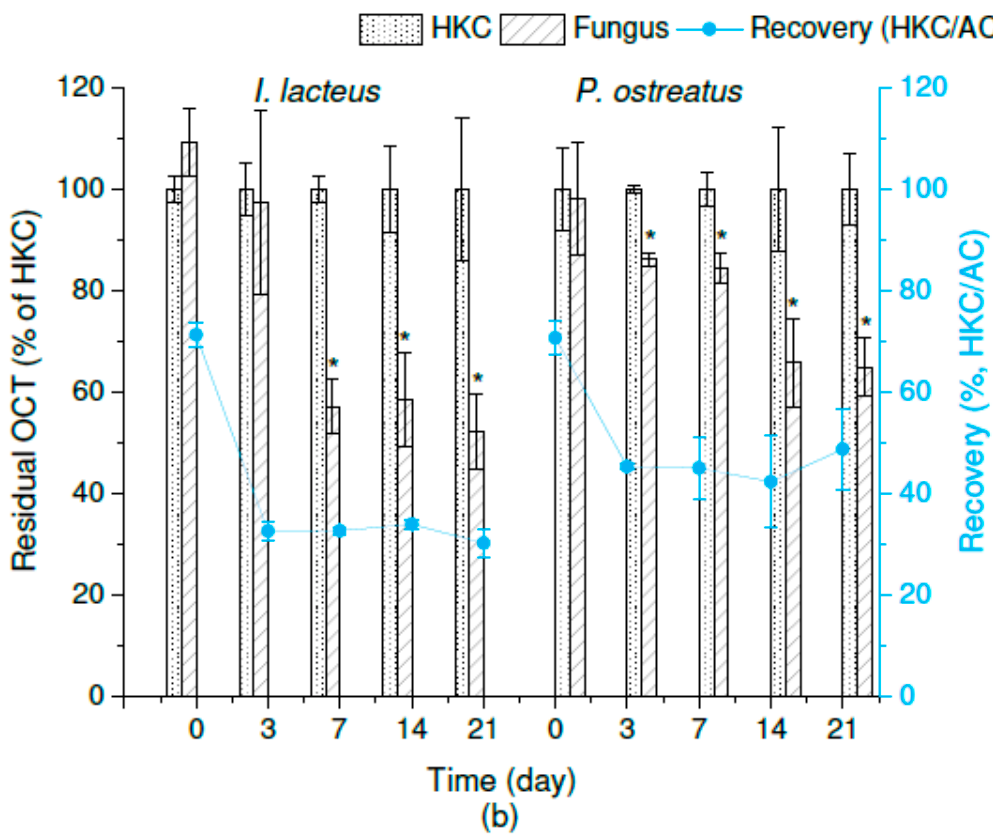
Figure 1. Residual concentration of ( a ) chlorhexidine (CHX) and ( b ) octenidine (OCT) after the 21-day in vivo degradation by I. lacteus and P. ostreatus related to the respective heat-killed controls (HKCs). The red (CHX) and blue (OCT) line graphs show extraction recovery during the experiment expressed as the HKC and abiotic control (AC) ratio. Error bars represent standard deviation ( n = 3). The asterisk marks a significant difference between the individual harvesting day and the control group—0 d (post hoc Dunnett’s Test).